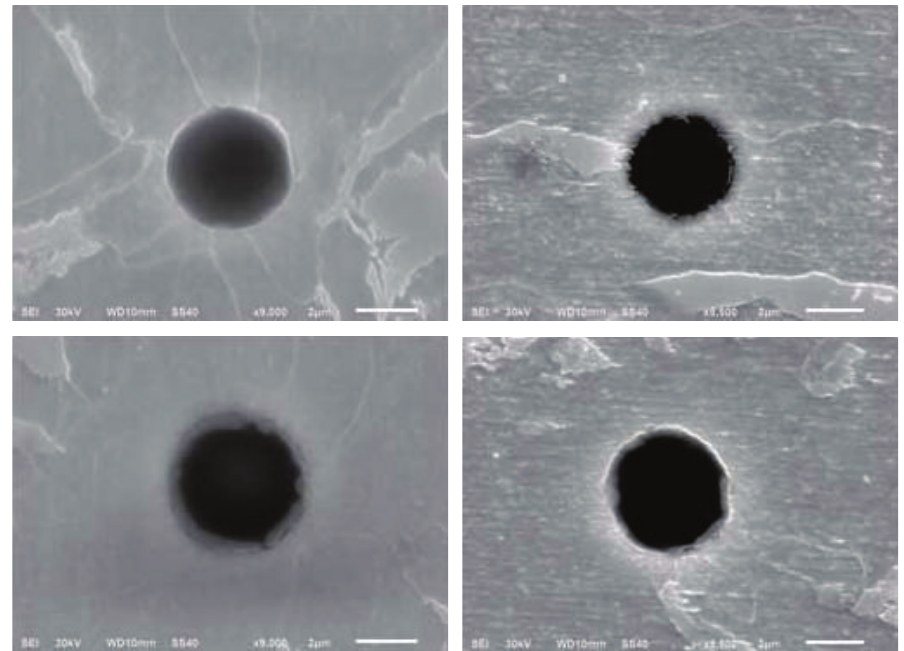
Figure 6: The diversity of nucleation effect induced by four typical Mg-Al-O